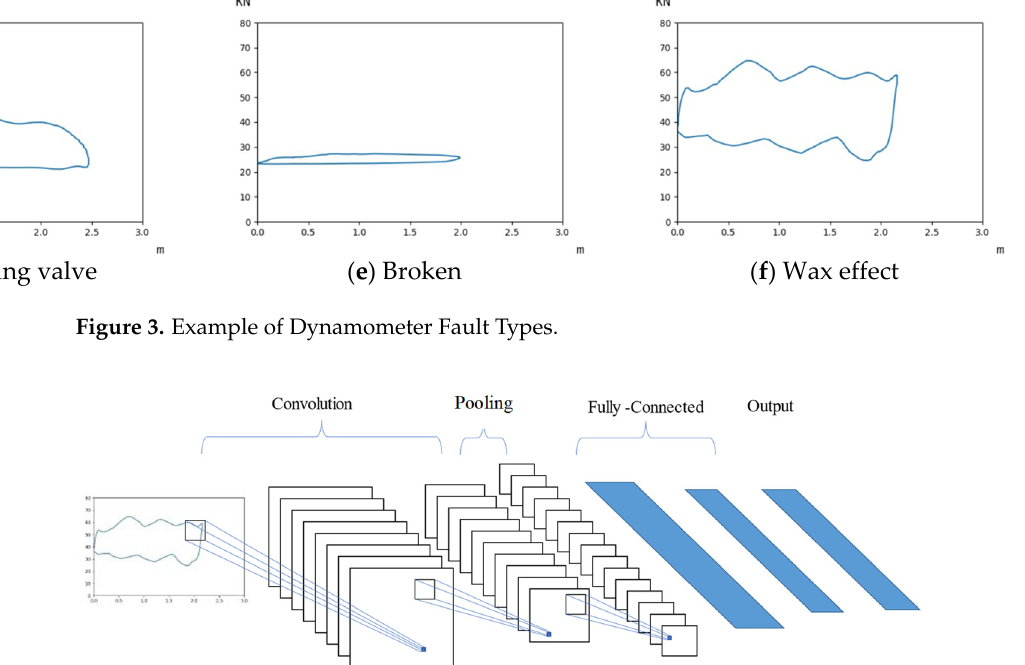
Figure 4. Diagram of convolutional neural network image recognition process.